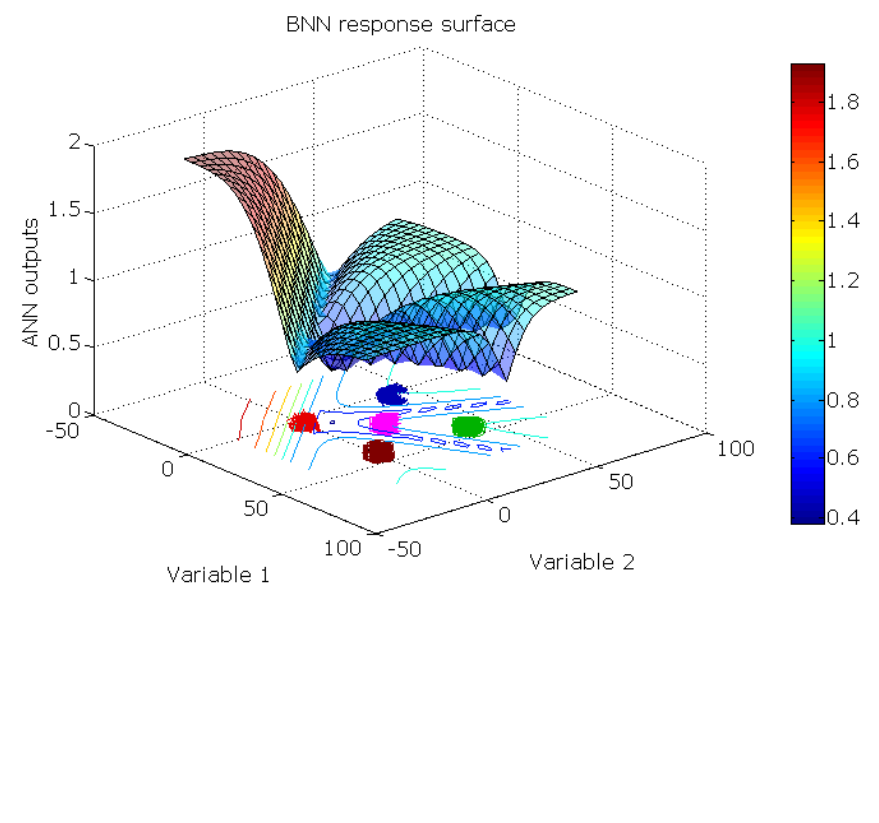
Figure 8. The BNN response surface of the synthetic novel class data set. For each sampling point, the maximum of the output neurons is